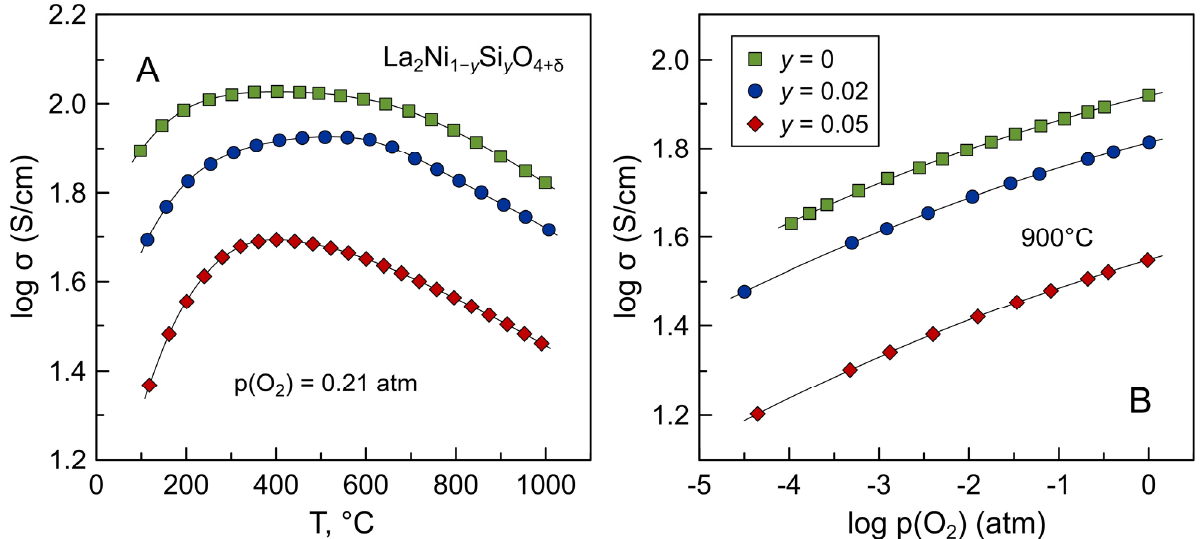
Figure 6. Electrical conductivity of La 2 Ni 1 − y Si y O 4+ δ ceramics as a function of temperature in air ( A ) and as a function of oxygen partial pressure at 900 °C ( B ).